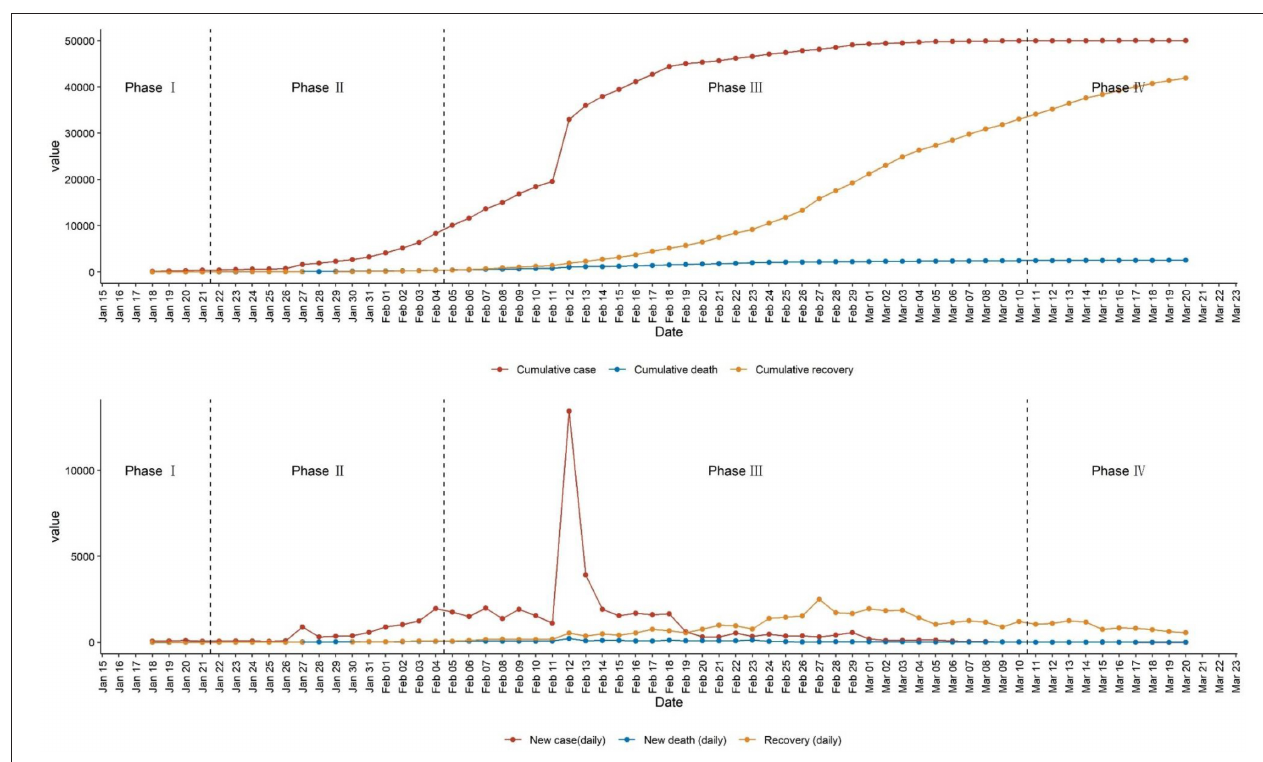
FIGURE 1 | Confirmed cases, death cases, and recovery cases of COVID-19 in Wuhan. This figure shows the results for or from confirmed cases. Before March 10, 2020, suspected cases are determined based on both clinical manifestations (two of following three manifestations: 1, Fever; 2, has imaging features of pneumonia; and 3, the total number of white blood cells is normal or decreased, or the lymphocyte count is decreased) and contact history (one of following three histories within 14 days before the onset of illness: 1, Have travel history or residence history in areas where the COVID-19 case continues to spread; 2, Contact with patients with fever or respiratory symptoms from areas where the COVID-19 case continues to spread; 3, There is a cluster of disease or an epidemiological association with the new coronavirus infection). Suspected cases are confirmed cases with one of the following two pieces of evidence: 1. Respiratory tract specimens or blood specimens’ real-time fluorescent RT-PCR detection of new coronavirus nucleic acid positive; 2. Respiratory tract specimens or blood specimens’ virus gene sequencing, and known new coronavirus Virus highly homologous. After March 10, 2020, the corresponding standards have become stricter. Suspected cases